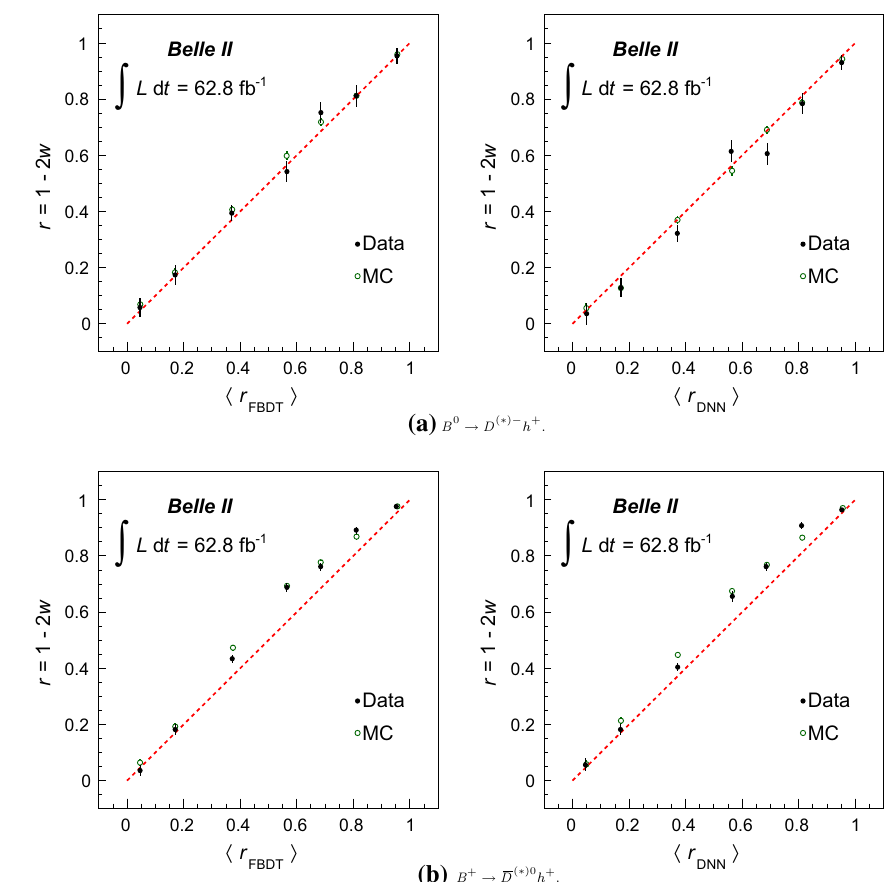
Fig. 13 Dilution factor r = 1 − 2 w as a function of the mean dilution (cid:12)| q · r |(cid:13) provided by the (left) category-based and (right) DNN flavor tagger in data and MC simulation for (top) neutral and (bottom) charged ( ∗ ) + B → D h candidates. The red dashed lines correspond to a linear function with an intercept at zero and a slope of one, corresponding to a perfect agreement between predicted and measured dilution